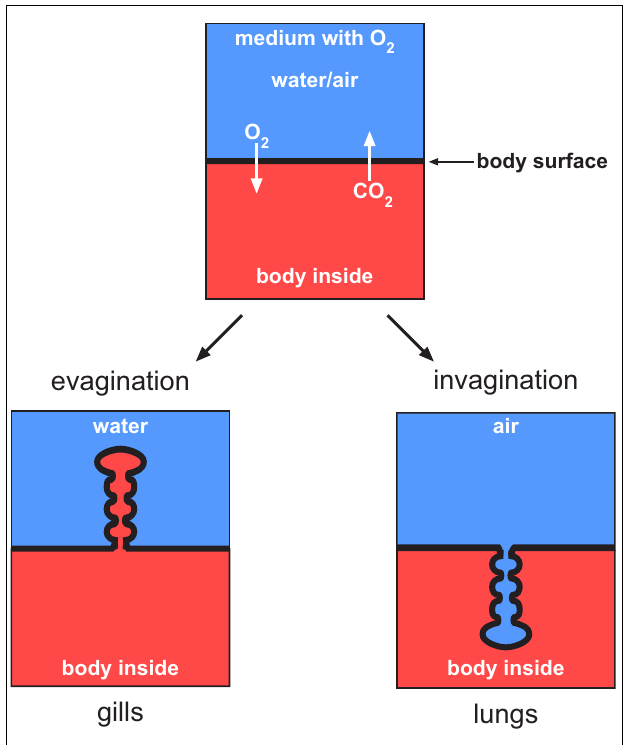
FIGURE 1 | Gas exchange can occur across the body surface simply by diffusion. This is the case in small animals and microorganisms. In vertebrates the diffusion rate across the body surface does not cover the entire oxygen demand that is needed to facilitate metabolism.Therefore parts of the body surface have been developed that are adapted for gas exchange. A particular feature of these surfaces is represented by compartmentalization to ensure sufficient gas diffusion. In water living vertebrates the body surface area is enlarged toward the environment whereas in air-breathing vertebrates the surface is invaginated to avoid